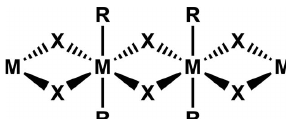
Figure 3 The targeted one-dimensional Cd II -based coordination polymer ( M = Cd, X = halide ion and R = 2-pyz , 4-pym or 4-quz